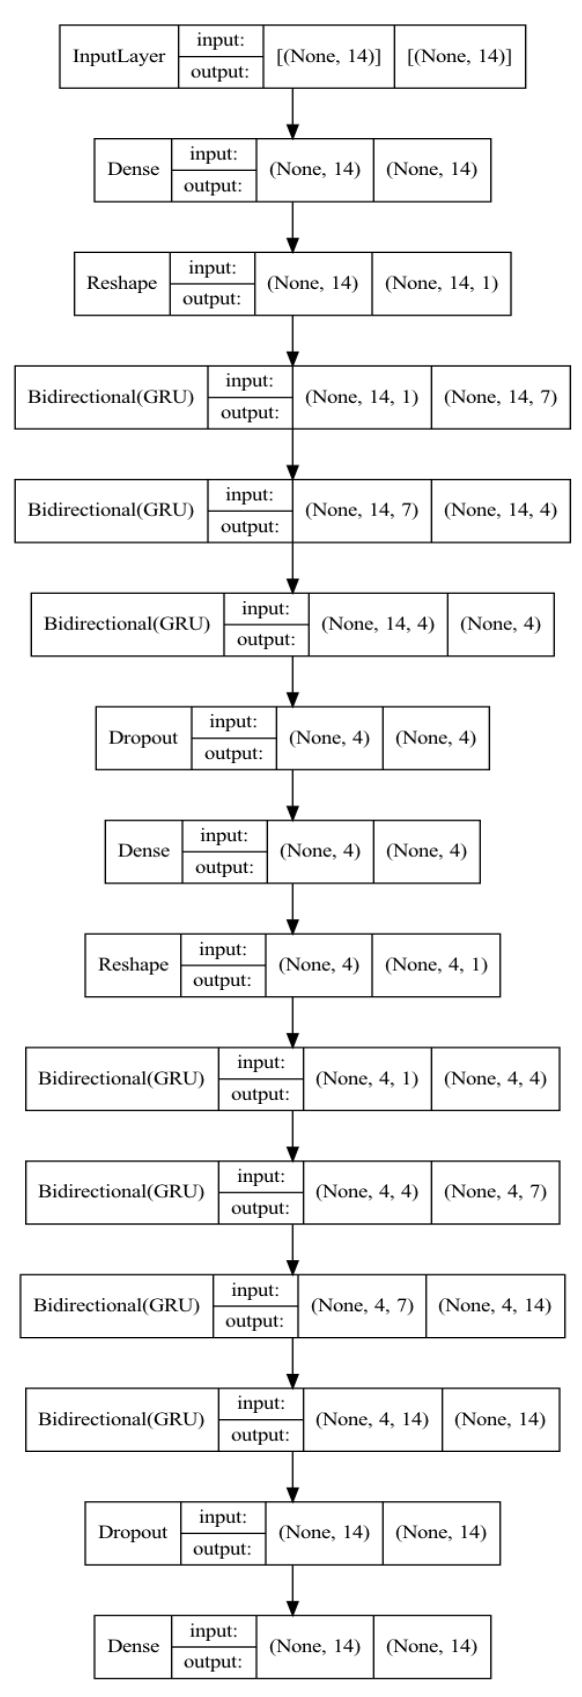
Figure 10. Autoencoder model of